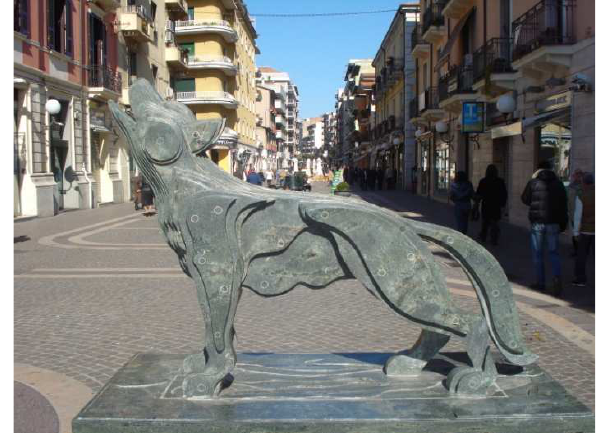
Figure 2. The Wolf of Sila